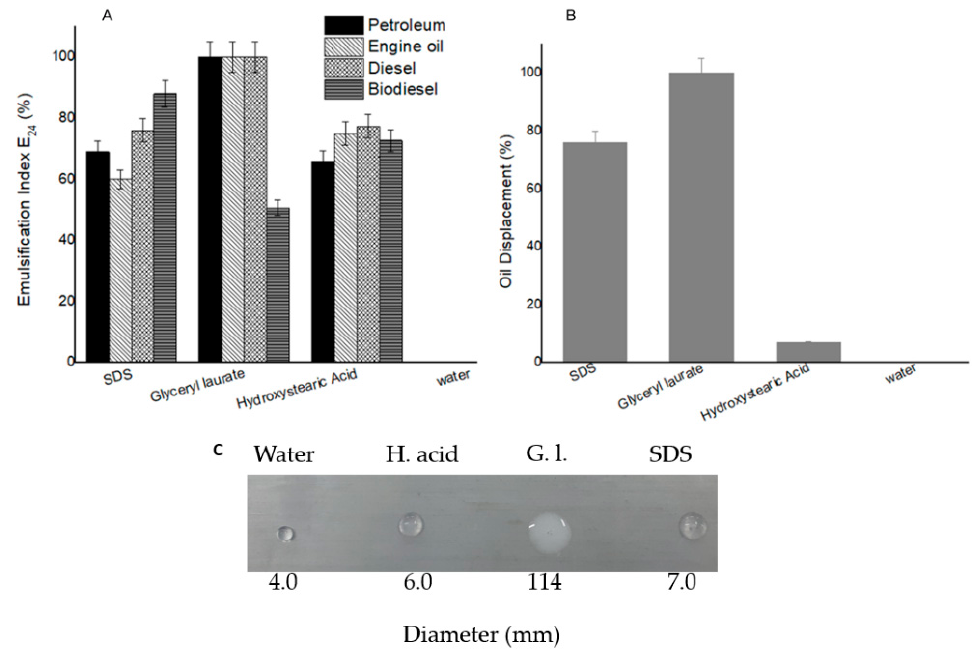
Figure 1. ( A ) Values of emulsification index after 24 h, ( B ) engine oil dispersion for biobased surfactants versus conversion surfactant (SDS) and ( C ) drop collapse results. Error bars show standard error from triplicate measurements. Subtitle: H. Acid (hydroxystearic acid); G.L (glyceryl laurate).